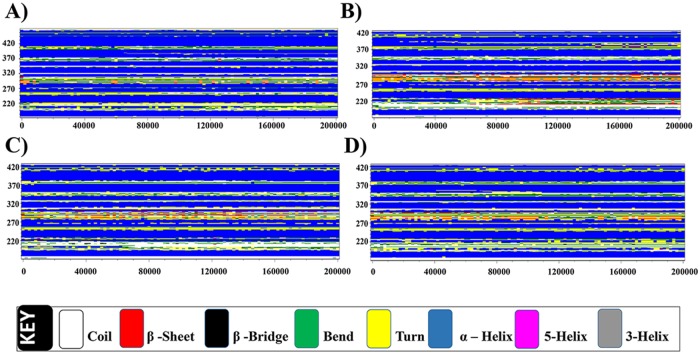
Time evolution of secondary structure analysis of (A) VDRapo (B) VDR1α25(OH)2D3(C) VDRCTA-091 and (D) VDRCTA-018.